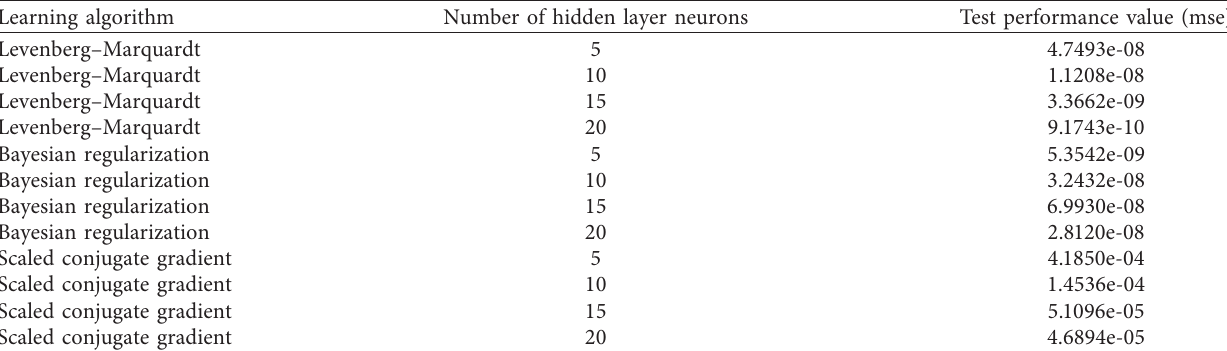
Table 4: The performance of the network in different learning algorithms and different hidden layer neuron